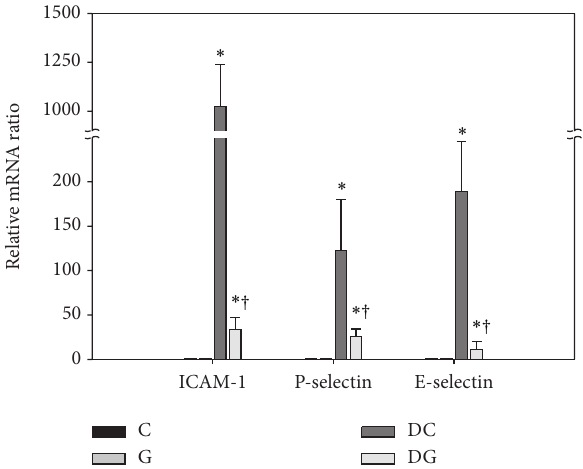
Figure 8: Gene expression of endothelial adhesion molecules in colon tissues. mRNA levels were analyzed by a real-time PCR. The C group was used as a calibrator, and the data were presented as the fold change in gene expression relative to the calibrator. Values are shown as the mean ± SEM. ∗ Significantly different from the C group ( 𝑃 < 0.05 ). † Significantly different from the DC group ( 𝑃 < 0.05